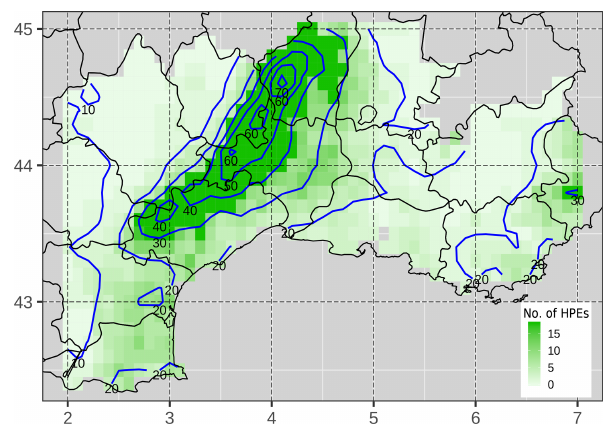
Figure 2. Annual average of HPE occurrence per grid point (in green). The composite of daily rainfall amounts (mmd − 1 ) of the HPE dataset is represented by the blue